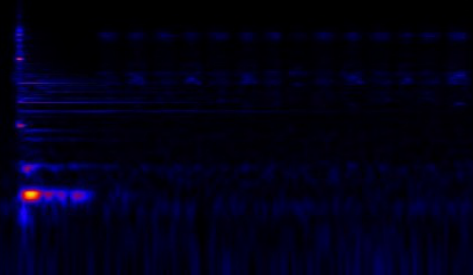
Fig. 19. Group II’s spectrogram of an amplified E3 note sustained with vibrato